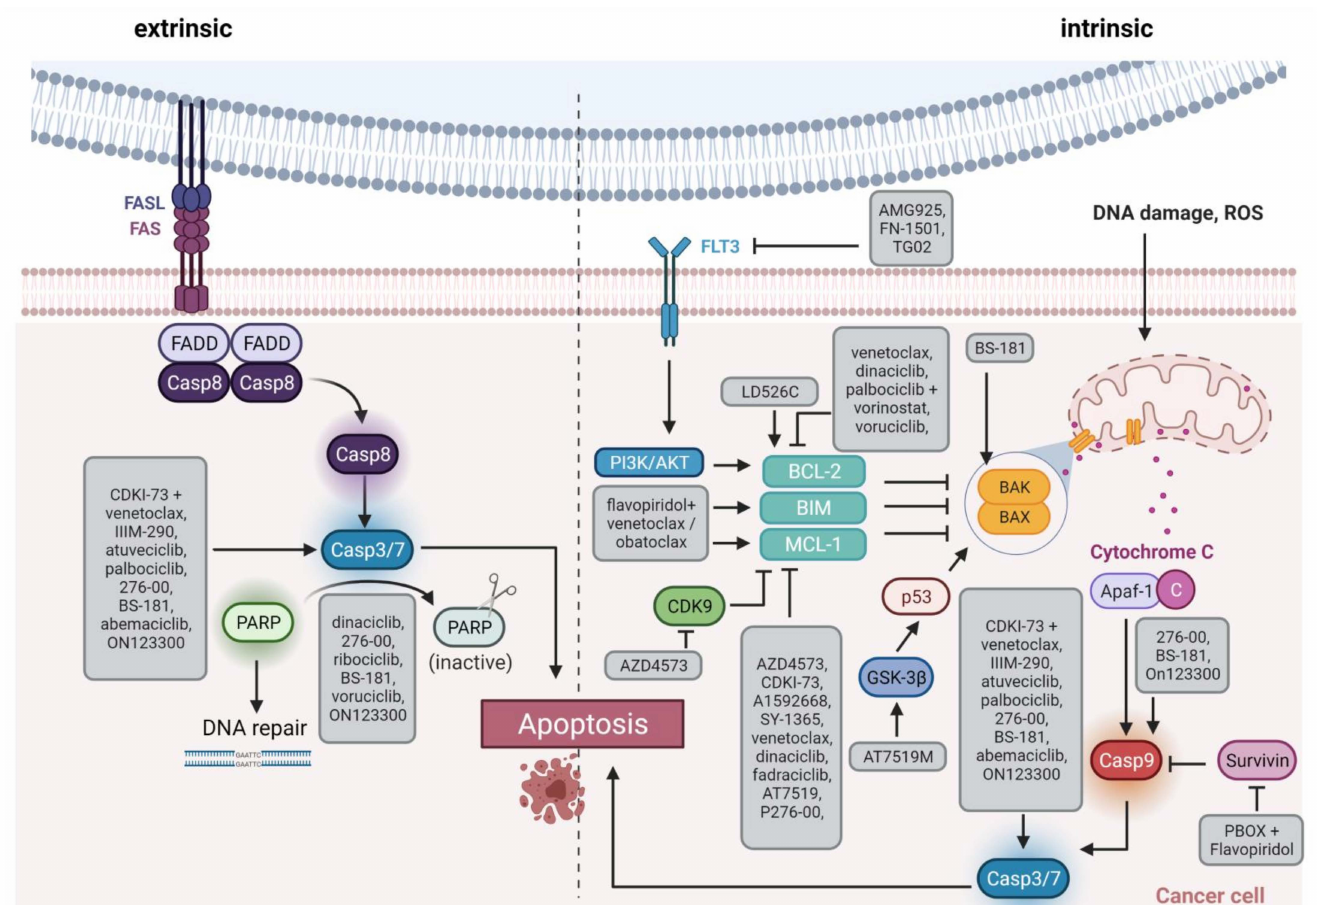
Figure 3. Schematic overview of apoptosis induction. The extrinsic pathway via Fas/FasL interaction is shown on the left side, and the intrinsic pathway via members of the BCL-2 family such as BAX/BAK on the right side. The highlighted boxes indicate the active form of the molecule. The gray boxes list therapeutic substances and how they influence apoptosis. FAS, Fas cell surface death receptor; FASL, FAS ligand; Casp, caspase, PARP, Poly(ADP ribose) Polymerase; FLT3, FMS related receptor tyrosine kinase 3; PI3K, phosphatidyl inositol 3 kinase; AKT, AKT serine/threonine kinase; ROS, reactive oxygen species; BCL-2, BCL2 apoptosis regulator; BIM, BCL2 like 11; MCL-1, MCL1 apoptosis regulator; BAK, BCL2 antagonist/killer 1; BAX, BCL2 associated X, apoptosis regulator; GSK-3 β , glycogen synthase kinase 3-beta; p53, tumor protein 53; Apaf-1, Apoptotic peptidase activating factor 1. Created with